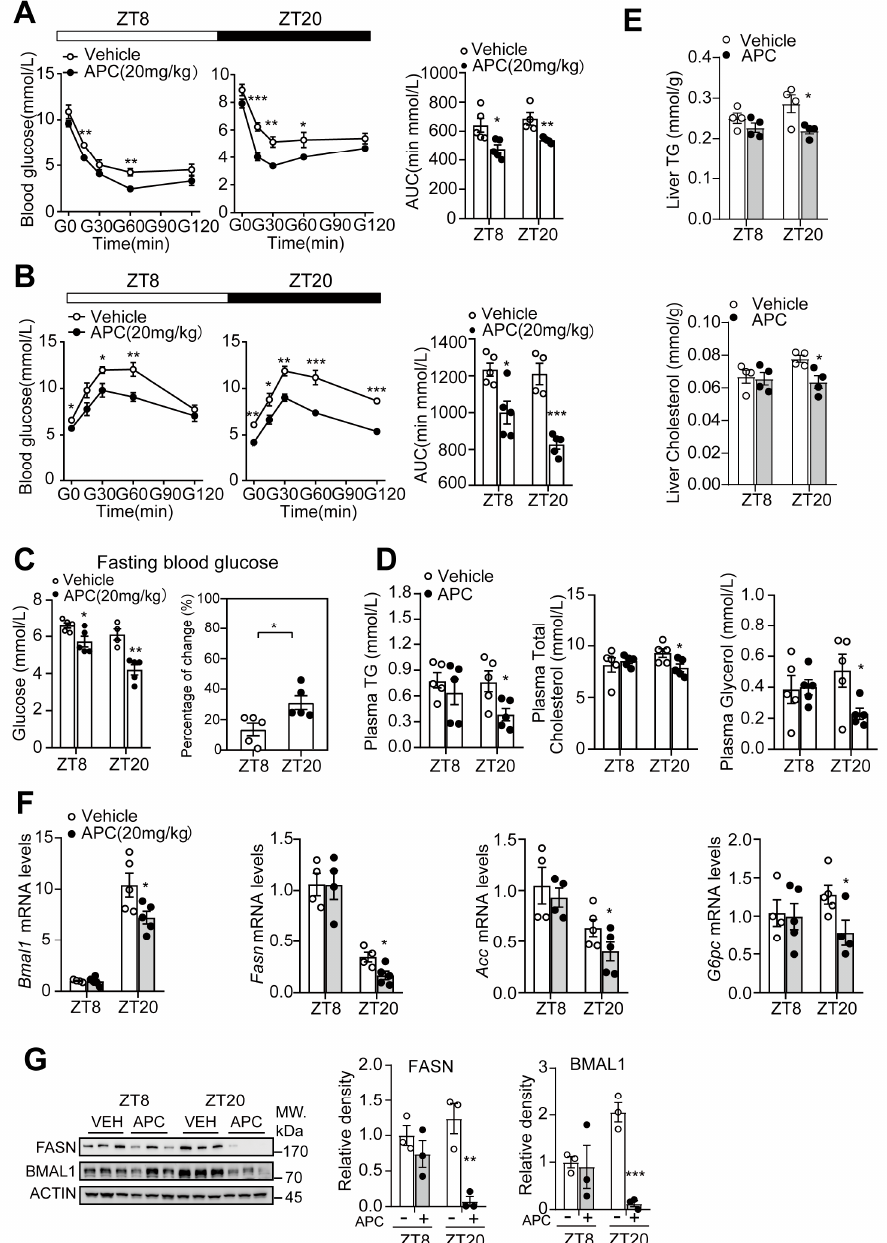
Figure 5. APC improved lipid and glucose homeostasis in DIO mice in a circadian rhythmic manner: ( A , B ) ITT and PTT were performed around ZT8 and ZT20. DIO mice were administrated APC or vehicle for 3 weeks. The results of area under the curve (AUC) are shown at the bottom of each test curve ( n = 5 per group); ( C ) the fasting blood glucose; DIO mice were treated by APC (20 mg/kg) or vehicle for 3 weeks ( n = 5 per group); after fasting for 16 h, the animals’ blood glucose was tested at ZT8 or ZT20; ( D ) the contents of plasma triglyceride (TG), plasma total cholesterol, and plasma glycerol in the DIO mice ( n = 5 per group); ( E ) the hepatic TG and TC levels in the DIO mice ( n = 4 per group); ( F ) mRNA levels expression of Bmal1 , Fasn , Acc, and G6pc genes analyzed by real − time qPCR in the livers. DIO mice were treated by APC (20 mg/kg) or vehicle for 4 weeks ( n = 5 per group); ( G ) Western blots of BMAL1 and FASN proteins in livers; the db/db mice were treated as ( F ). * p <0.05; ** p < 0.01; *** p < 0.001.